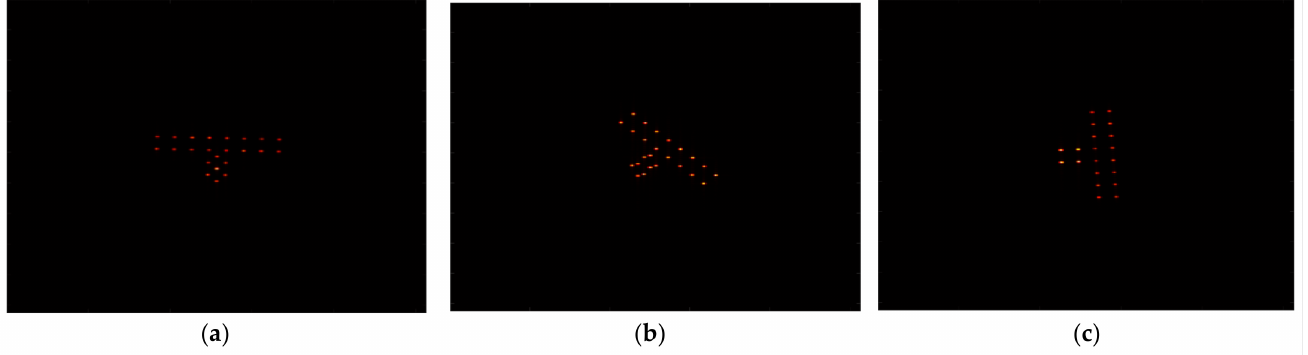
Figure 8. Simulated ISAR image sequence of the non-rotating space target. ( a ), ( b ), and ( c ) are the 1st, 13th, and 24th frames, respectively.